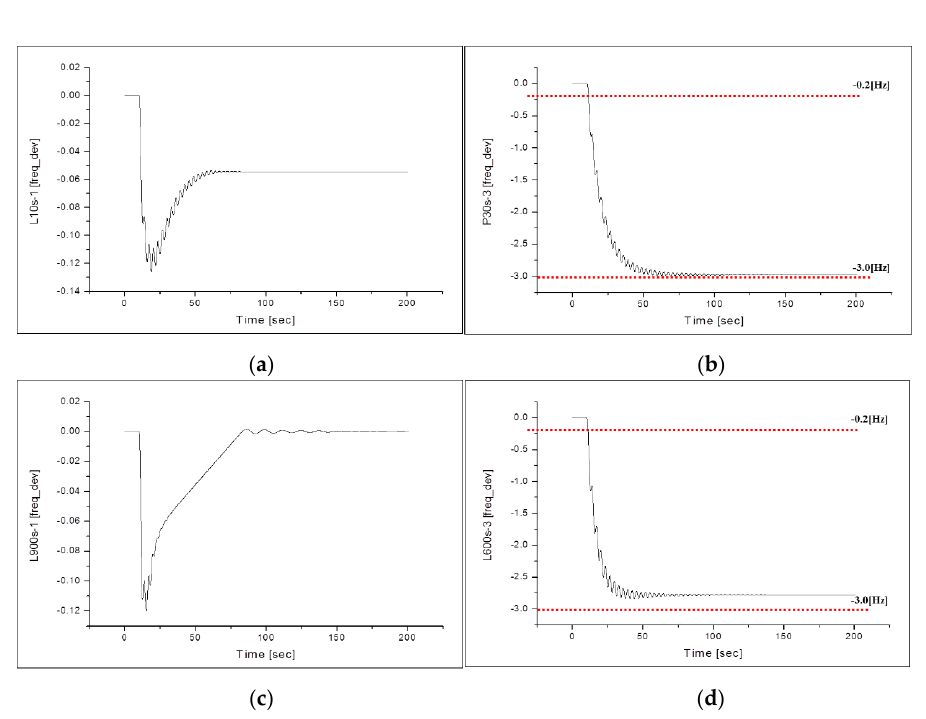
Figure 11. Frequency deviation of the load fluctuation (P company, summer season): ( a ) GF response characteristics (light load 10 s-1 σ ); ( b ) GF response characteristics (peak load 30 s-3 σ ); ( c ) AGC response characteristics (light load 900 s-1 σ ); ( d ) AGC response characteristics (light load 600 s-3 σ ).